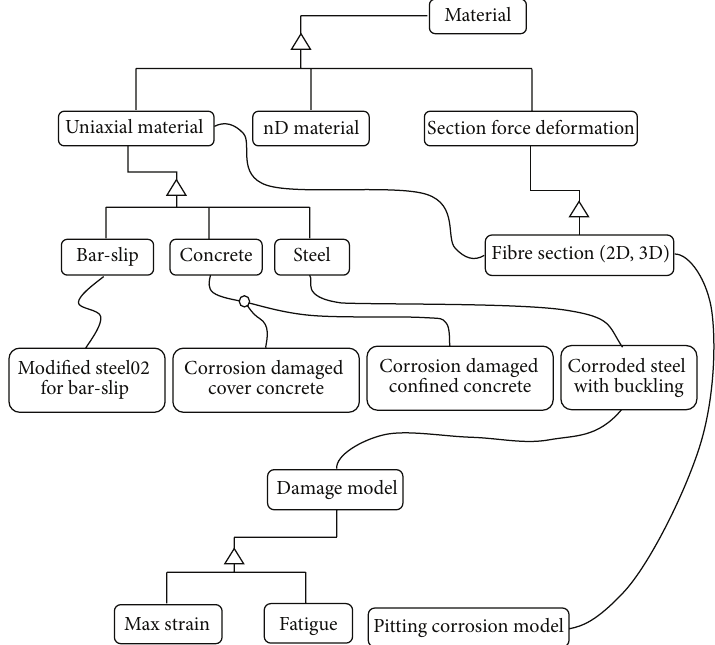
Figure 2: Implementation of the corrosion models within the OpenSees abstract